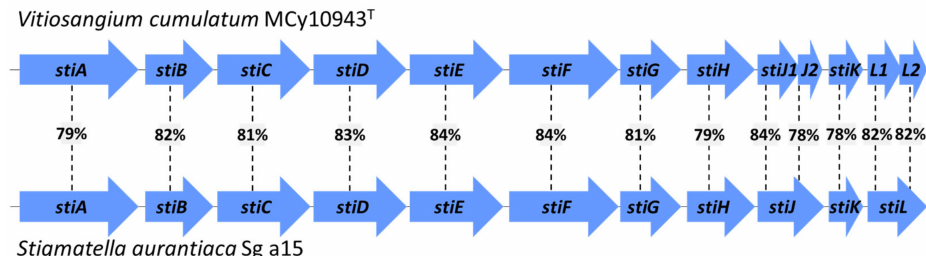
Figure 4. Comparison of the stigmatellin BGC from V. cumulatum MCy10943 T and S. aurantiaca Sg a15. Percent in rectangles highlights identity score in BLAST